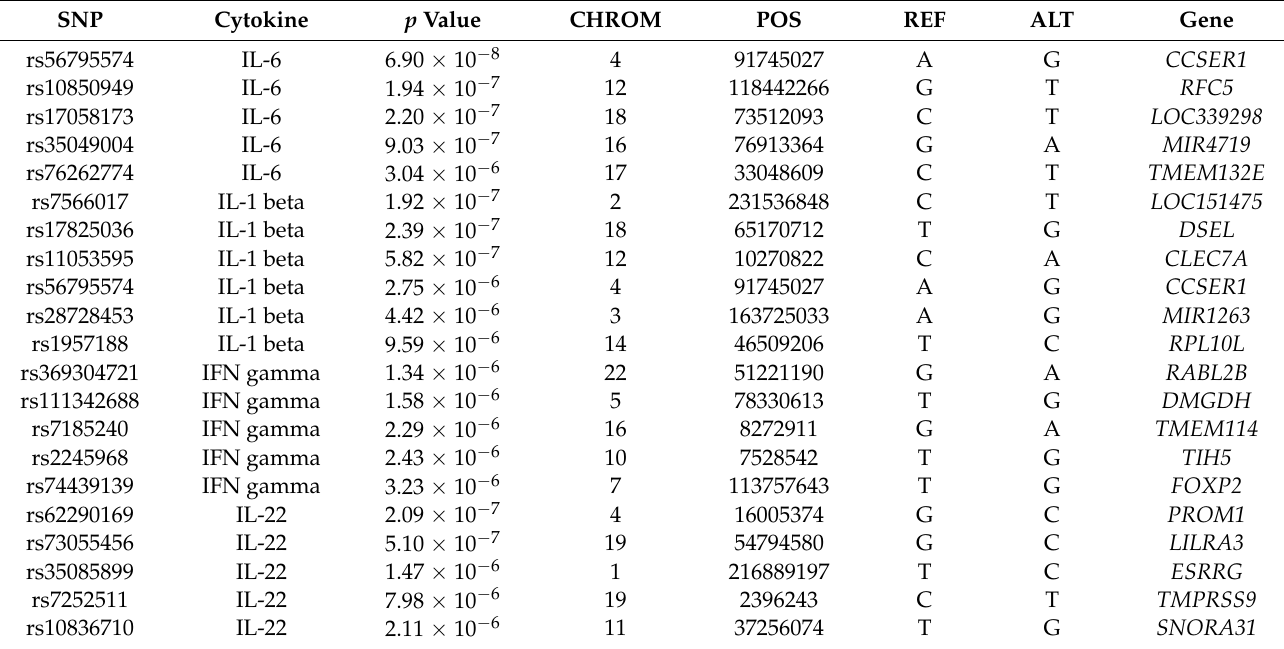
Table 1. Results of cQTL mapping analyses ( p < 5 × 10 − 6 ).